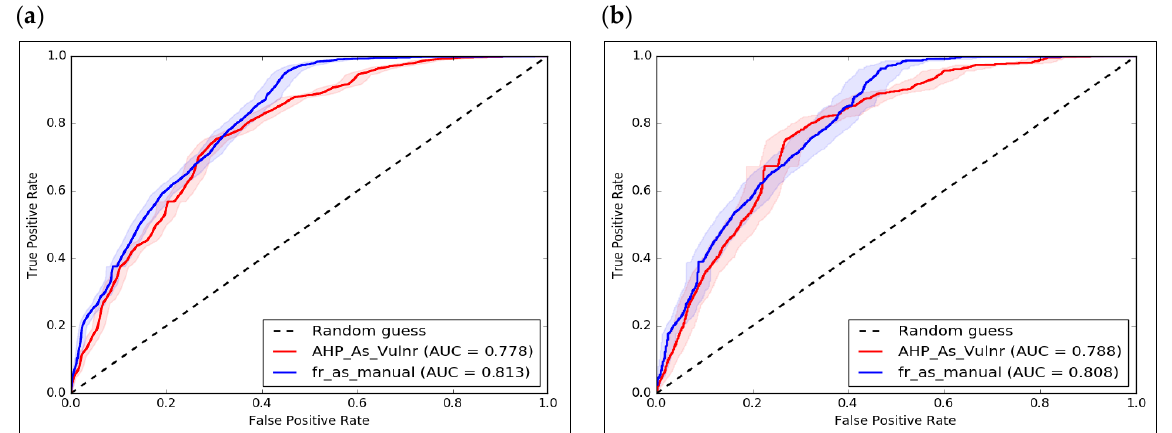
Figure 6. ( a ) AUROC validation curve with training datasets for the AHP and FR methods; ( b ) AU- ROC validation curve with testing datasets for the AHP and FR methods.